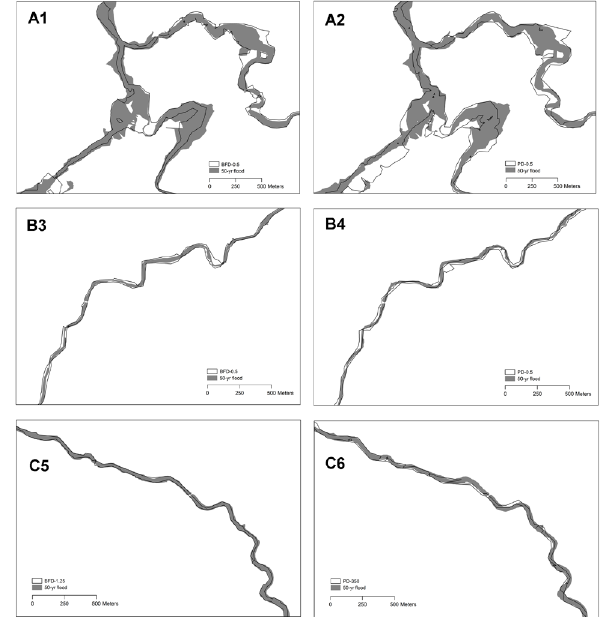
Fig. 10. Adjustment between the 50-yr flood and the optimal geo- morphological floodplain surfaces for bankfull depth (1, 3 and 5) and path distance (2, 4 and 6) approaches in open valleys ( A ), shal- low vee valleys ( B ) and deep vee valleys ( C